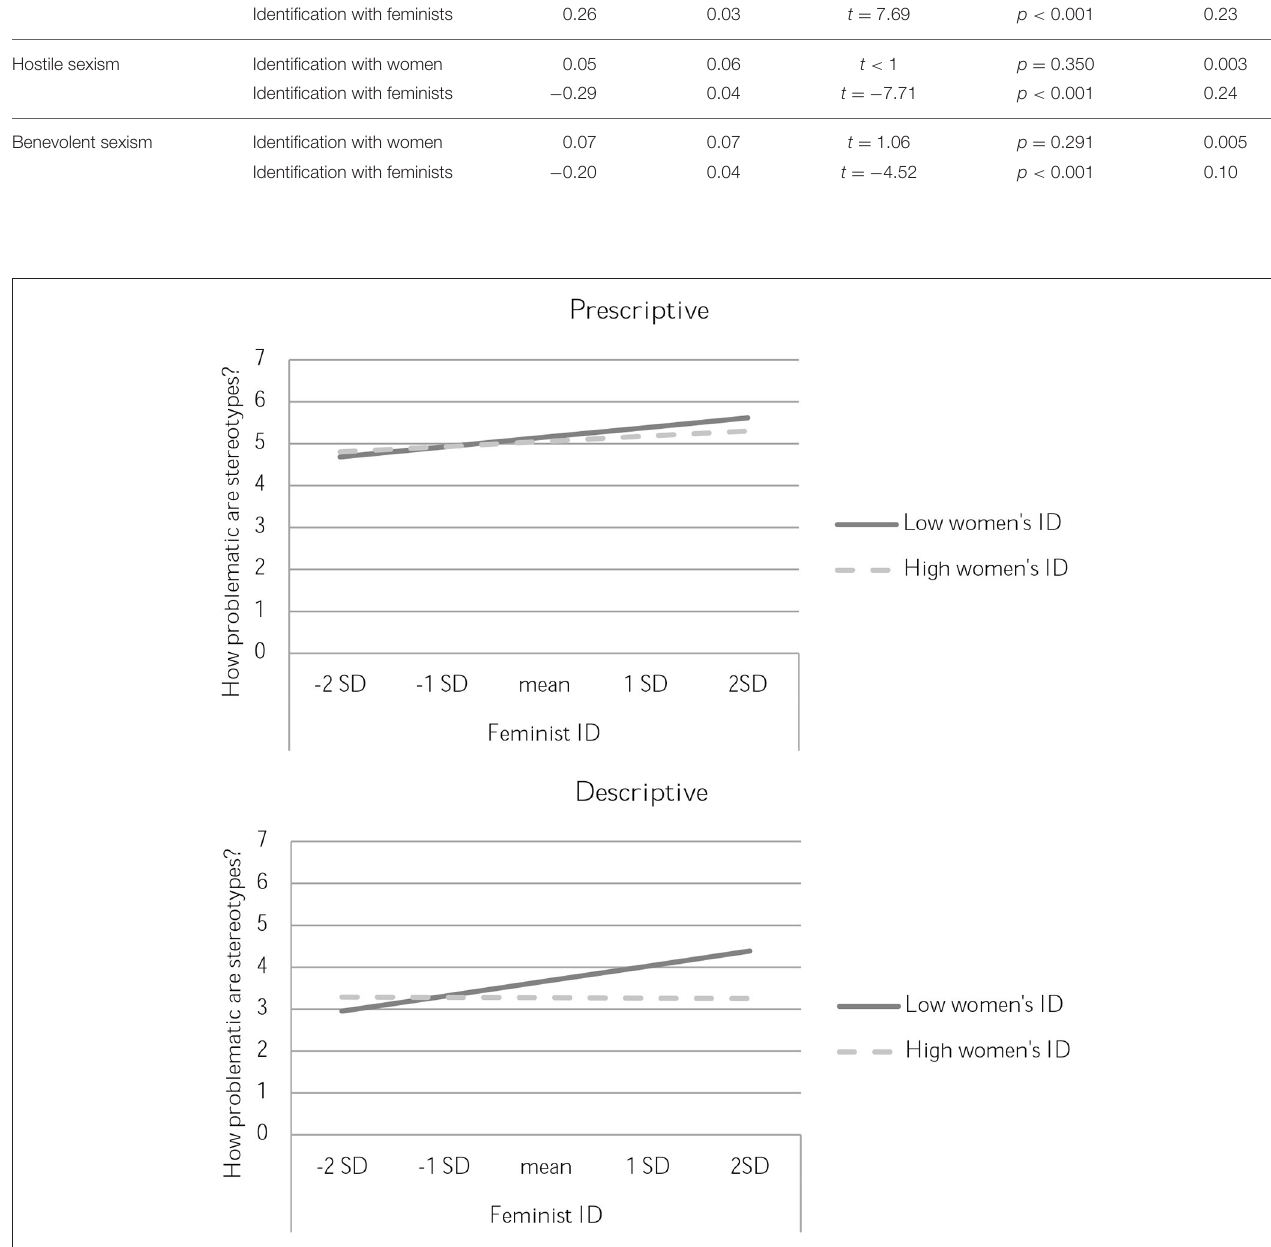
Frontiers in Psychology |